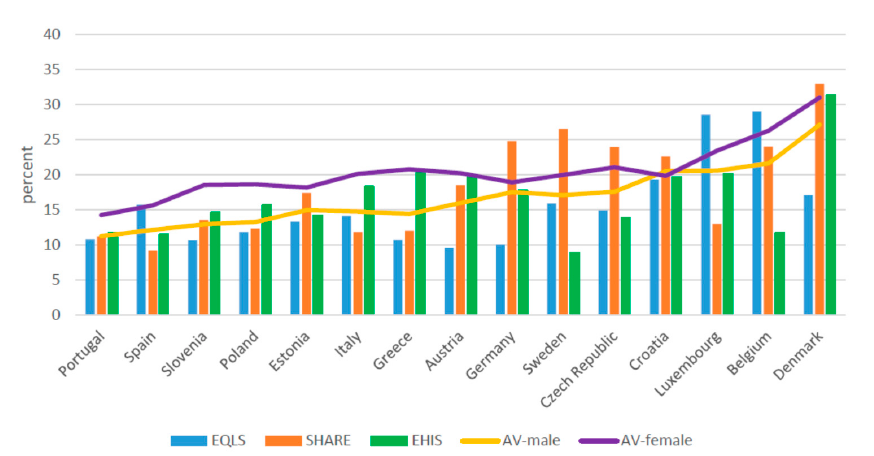
Figure 2. Informal Caregivers over 50 among males (weighted) (percent). EQLS = European Quality of Life Survey; SHARE = Survey of Health, Ageing and Retirement in Europe; EHIS = European Health Interview Survey; AV = Average.